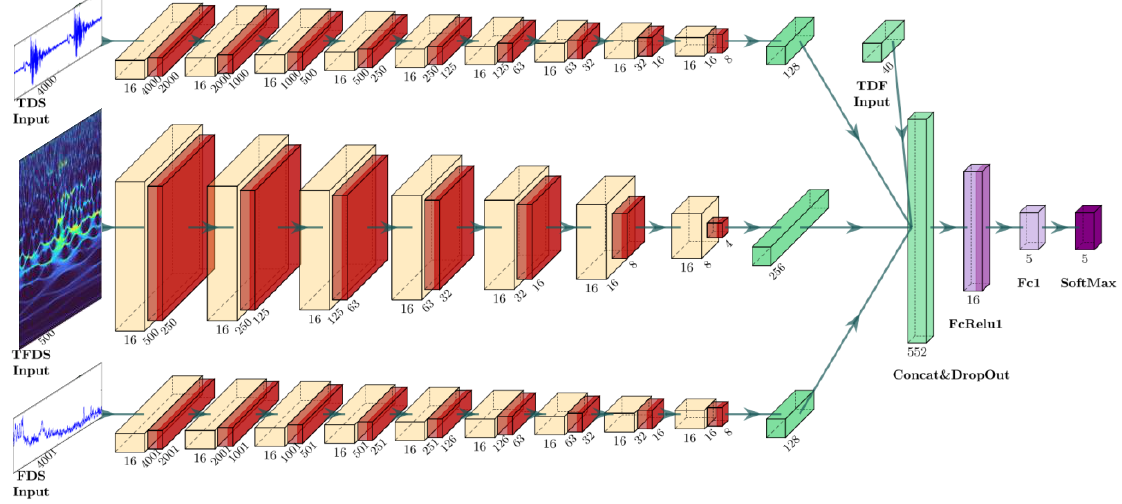
Figure 5. The MFICNN model structure.